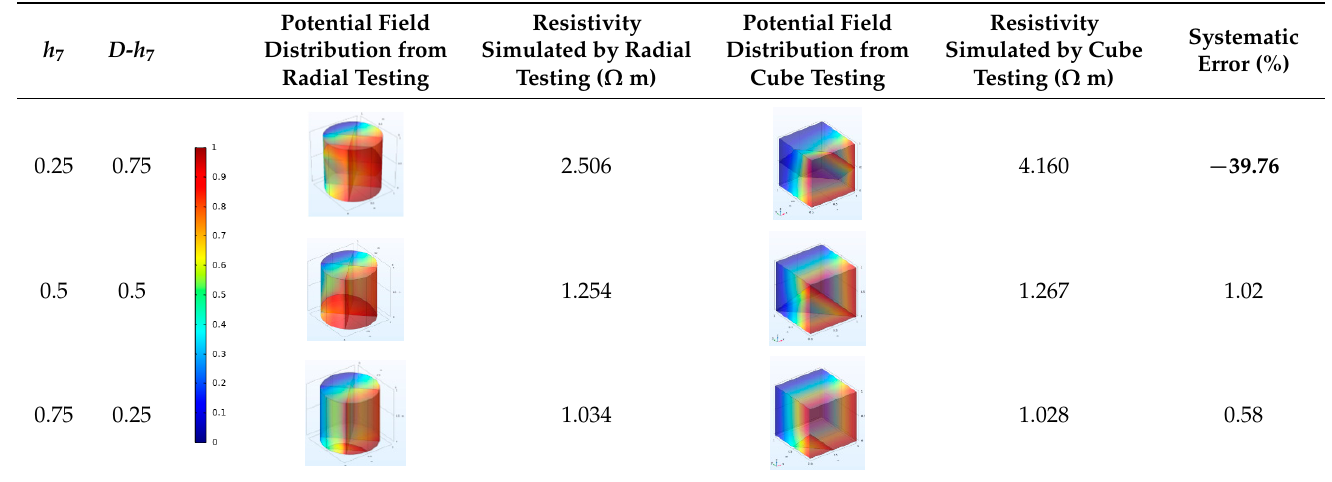
Table 6. Transitional Case 3 (transition from Extreme 1, Extreme 2, and Extreme 3): numerical simulation results of different material thicknesses.